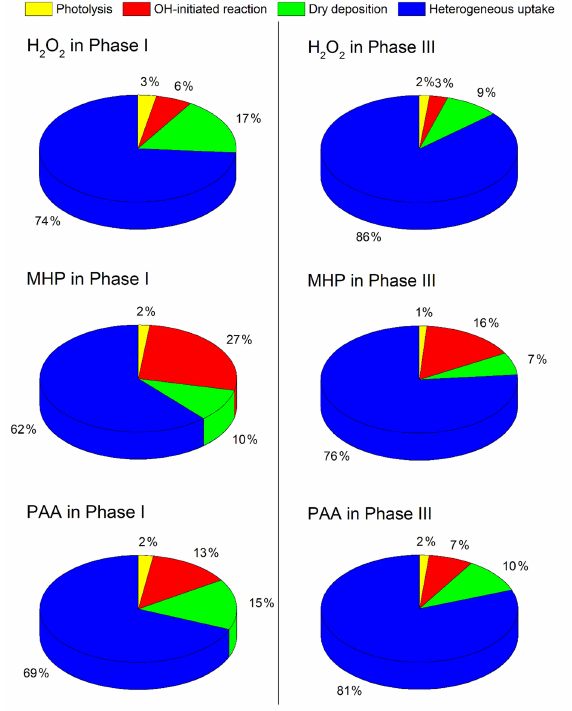
Figure 6. Contributions of each sink to H 2 O 2 , MHP and PAA destruction in the box model with the heterogeneous uptake by aerosols added during Phase I and Phase